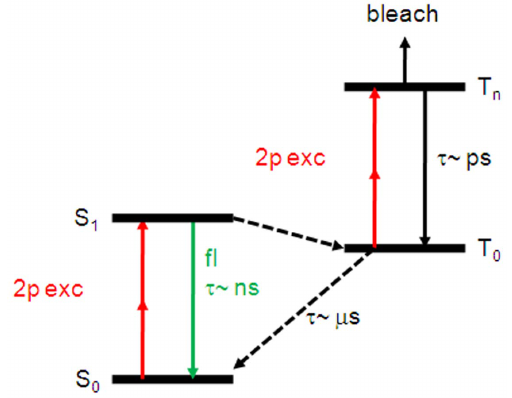
Figure 2. Energy diagram showing the photobleaching path- way via the triplet state. The fluorescence (fl) lifetime of the excited state S 0 is typically a few to several ns. When trapped in the triplet state (T 0 ), it will take , m s to relax to the ground state. Further excitations form the triplet states are more likely to bleach the